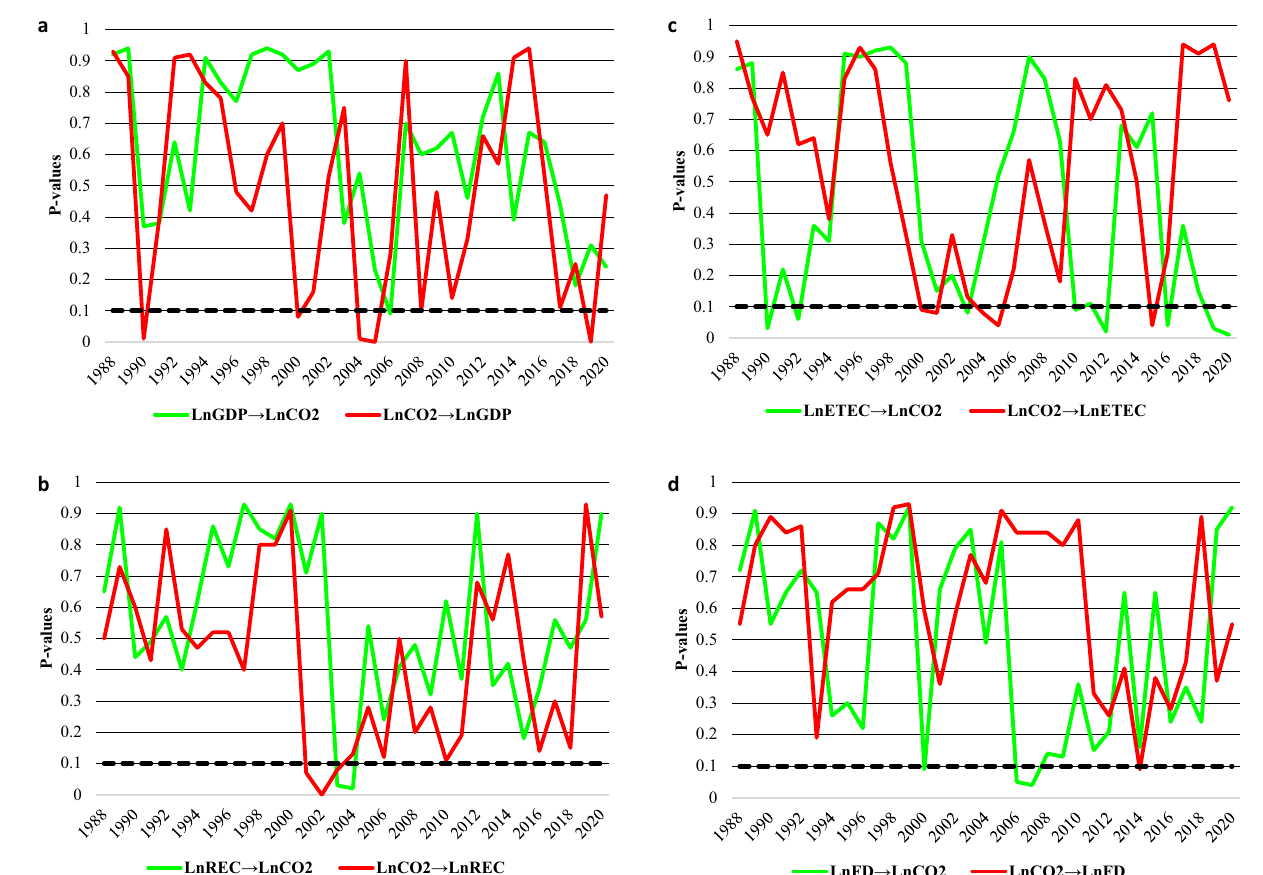
Figure 5. ( a ) Causality between economic growth and CO 2 , ( b ) Causality between renewable energy and CO 2 , ( c ) Causality between related environmental technologies and CO 2 , ( d ) Causality between financial development and CO 2